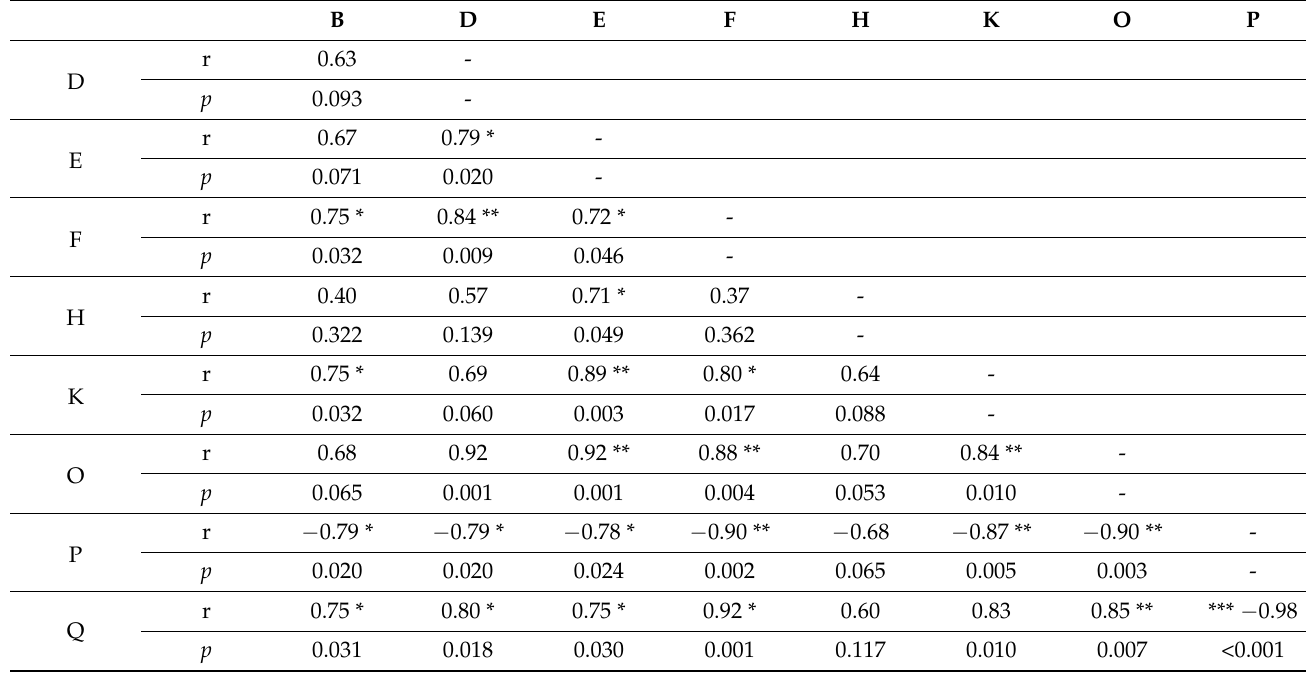
Table 16. ‘R’ correlation coefficient significance for procedures whose correctness saw a significant change in the years